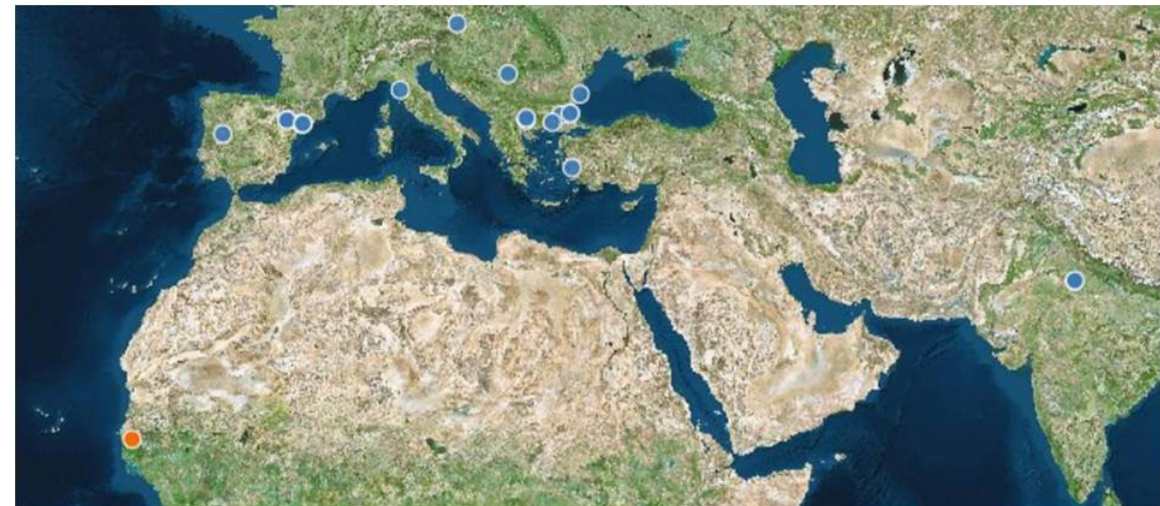
Fig 3 . Known distribution for Laboulbenia camponoti Batra, up to February 2017 (blue dots, known distribution; orange dot, new